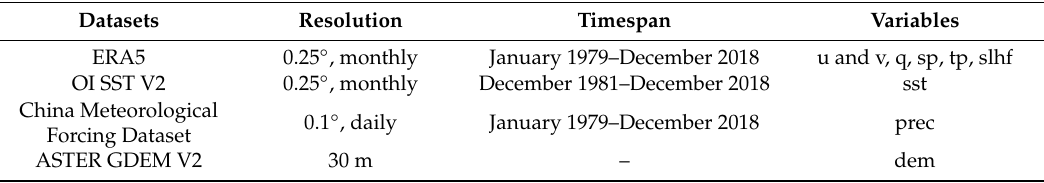
Table 1. Detailed information of all the datasets used in the